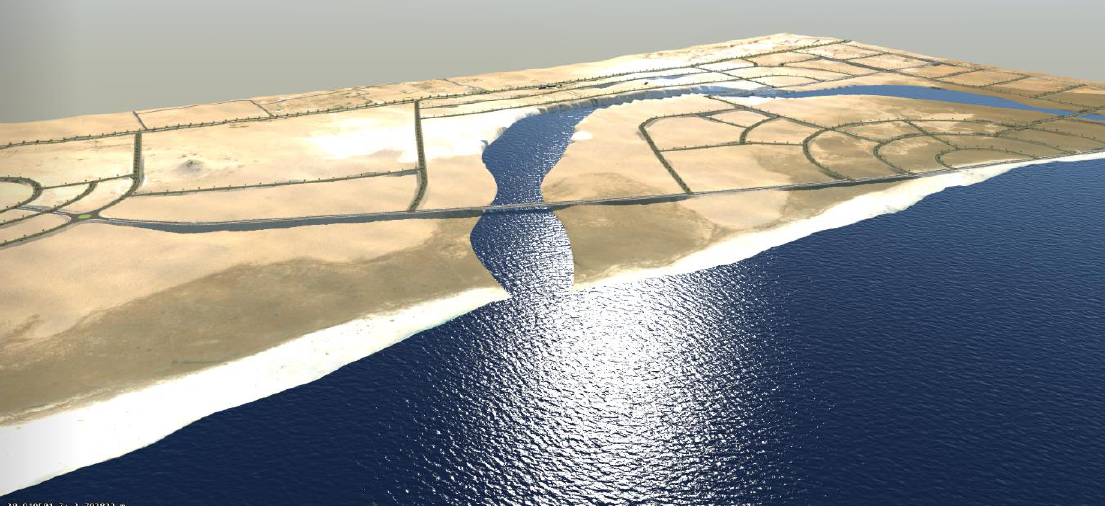
Figure 10: INFRA WORKS 360 (Roads – ALAMEIN).